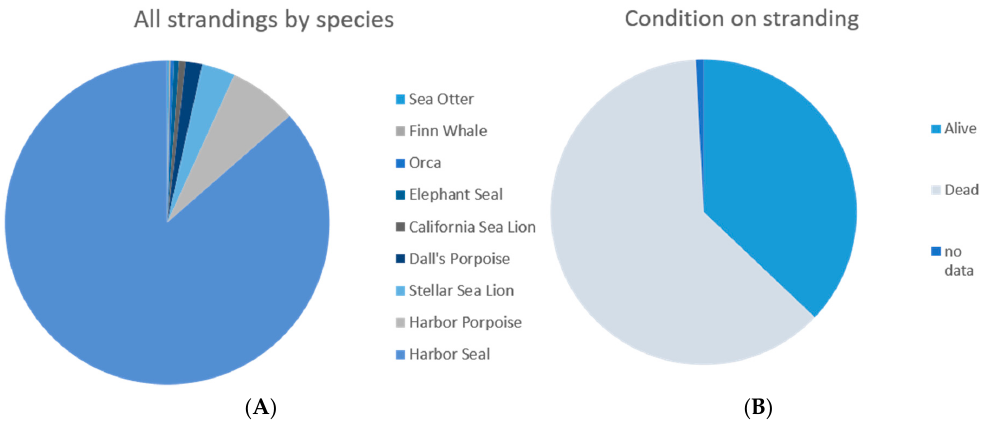
Figure 6. ( A ) Species breakdown, n = 604; ( B ) Stranding condition, n = 604.